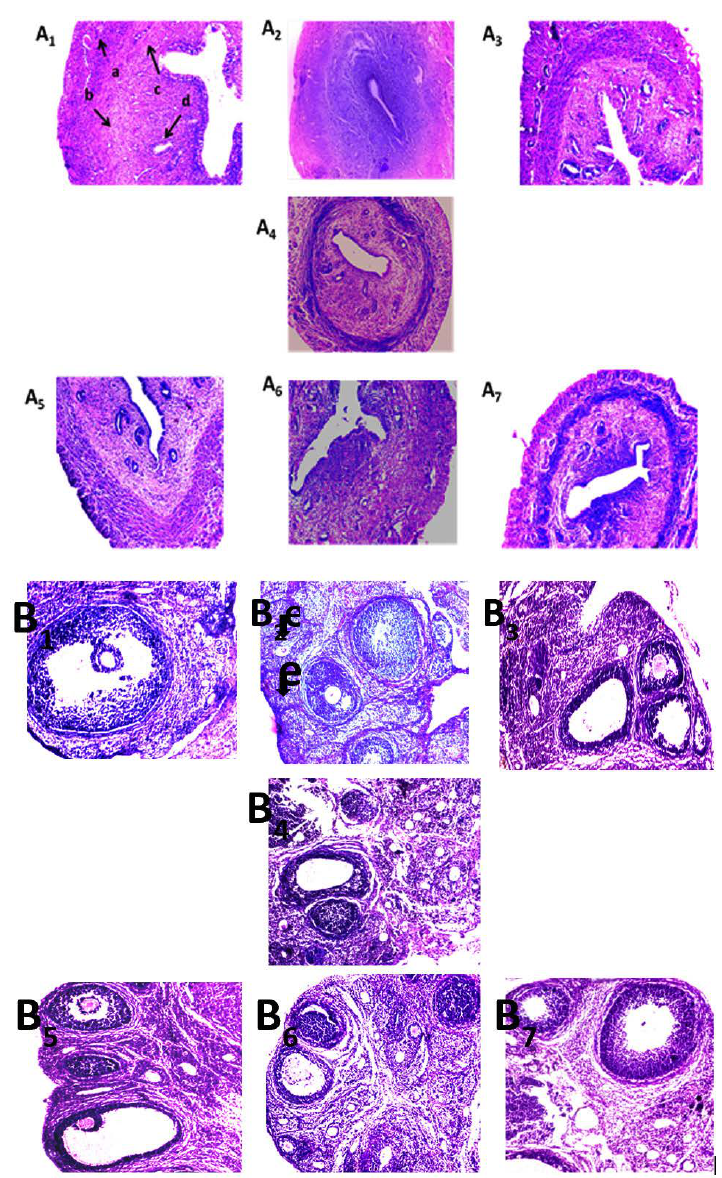
Fig. 2. Effect of spirulina and probiotics on histology of female reproductive organs. (A and B) Uterine and ovarian tissue were implanted in paraffin, serially sectioned laterally at 5 nm, stained with eosin and haematoxylin (Harris) and observed under a microscope (magnification x100) to study the uterine (A) and ovarian (B) histo-architecture. Arrow indicates in slide “d” the secretory glands and pictures showed in A the remarkable loss of secretary cells of 2 uterine tissue along with distortion of endometrial layer. The numbers of regressing follicles were increased in slide B in the arsenic exposed group where arrows indicate follicular atresia. Spirulina and probiotics dietay co-treatment 2 significantly protected such arsenic induced ovarian (Figure 4B , B , B ) and uterine (Figure 4A , A , A ) disorders. 4 6 7 4 6 7 Panel distribution; A : vehicle treated control, A : arsenic, A : S. platensis , A : arsenic + S. platensis ., A : probiotics, 1 2 3 4 5 A : arsenia+probiotics, A : arsenic + S. platensis + probiotics , B : vehicle treated control, B : arsenic, B : S. platensis , 6 7 1 2 3 B : arsenic + S. platensis . B : probiotics, B : arsenia+probiotics, B : arsenic + S. platensis + probiotics (a- perimetrium, 4 5 6 7 b- myometrium, c- endometrium, d- secretory cells, e- atretic